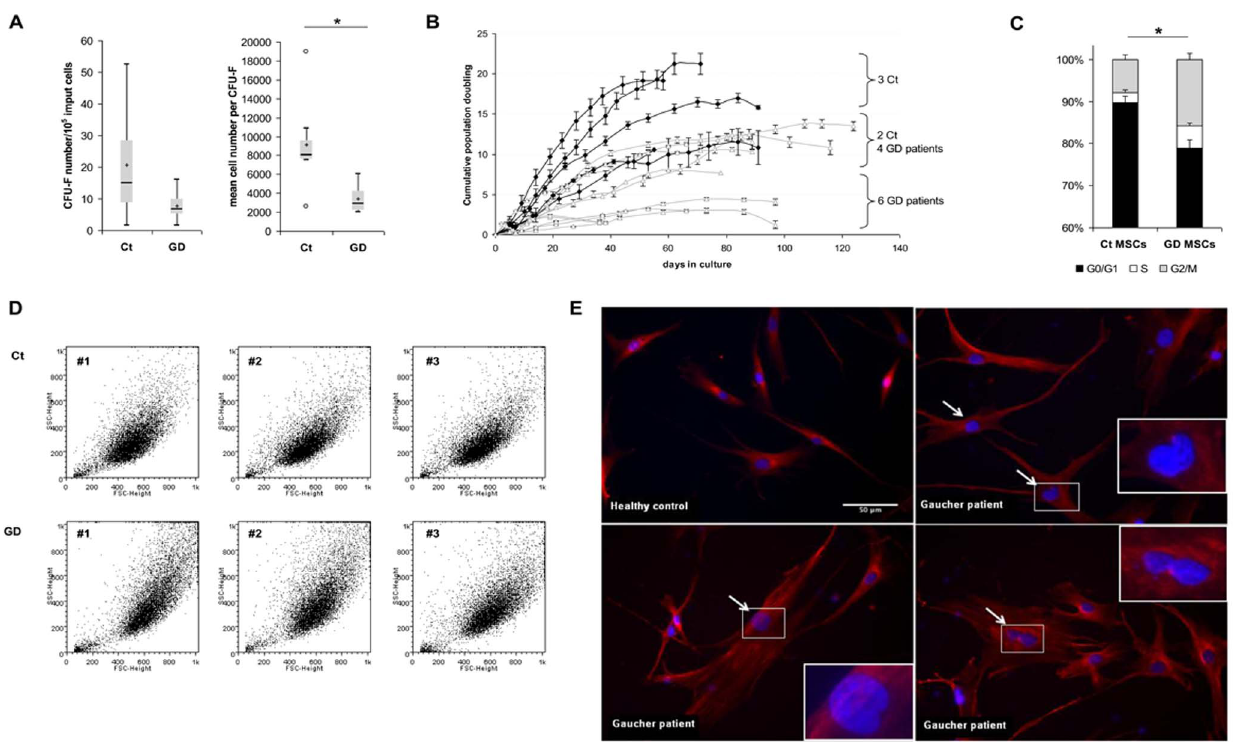
Figure 3. GD-MSCs characterization. (A) Histograms represents CFU-F quantification per 10 5 mononuclear cells (left panel) and mean cell number per CFU-F (right panel) obtained after culture of control (Ct) or GD BM samples (n=10 and 7 for GD patients and controls respectively). (B) MSCs growth kinetics: cumulative population doubling (CPD) are shown for Ct and GD-MSCs (n=5 and 10 respectively). (C) Cell cycle analysis was performed by flow cytometry on Ct and GD-MSCs. The percentage of cells in each phase of the cell cycle was determined by gating G0/G1, S and G2/ M cells (n=8 and 6 respectively). (D) Representative FSC/SSC flow cytometry profile of Ct and GD-MSCs. (E) Ct and GD-MSCs were stained with anti- alpha-tubulin (red) and with Hoechst for nuclear staining (blue). Typical non-round nuclei (angled panels) and large nuclei (arrows) were observed in GD-MSCs. Scale bars represent 50 m m. A and C: * indicates P , 0.05.